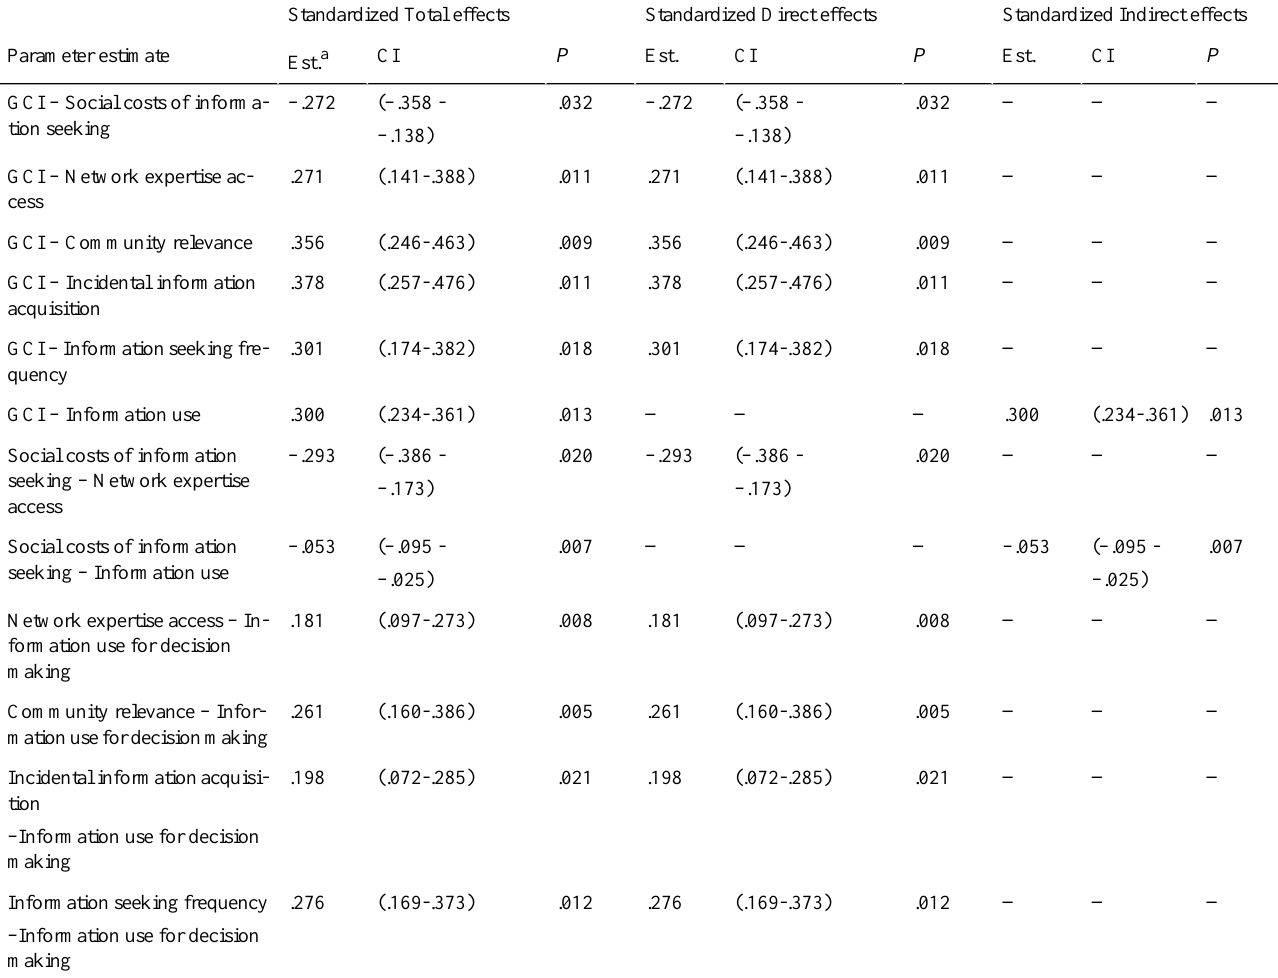
Table 6. Standardized total, direct and indirect path coefficients for model (see Figure 1) (N=194).